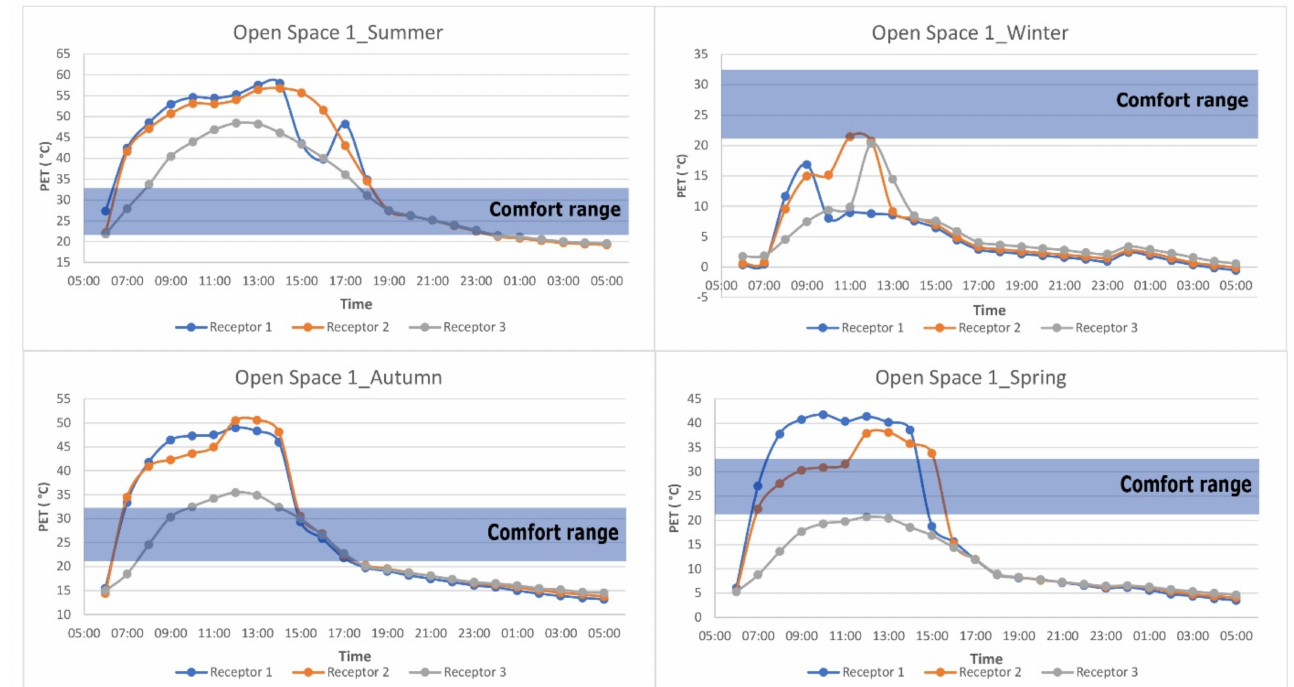
Figure 9. Open space 1 physiological equivalent temperature (PET) values throughout the